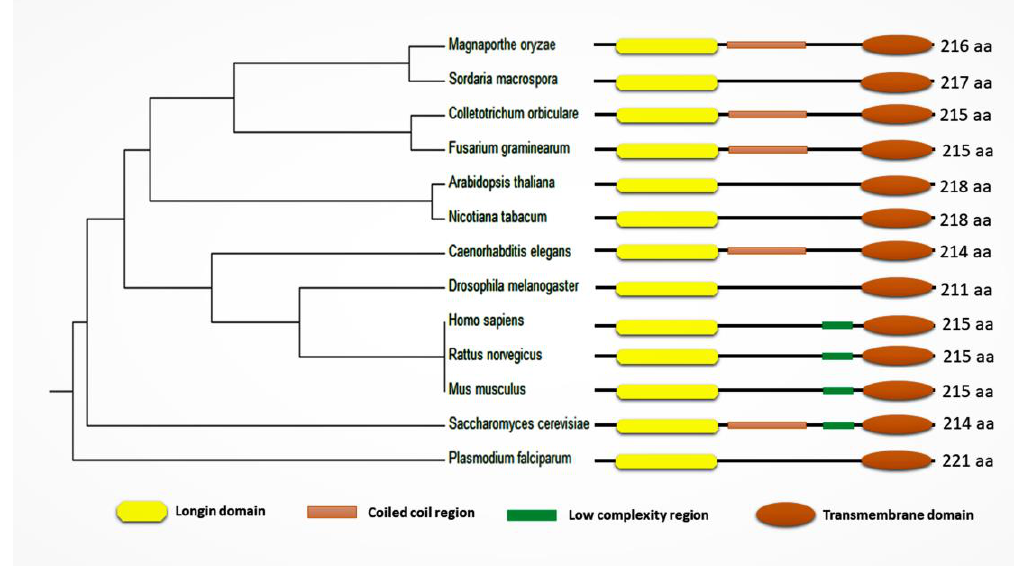
Figure 3. Phylogenetic analysis and domain characterization of Sec22 and its homologues (Sec22 of Saccharomyces cerevisiae and its homologues among different organisms including Homo sapiens , Mus musculus , Rattus norvegicus, Drosophila melanogaster , Caenorebditis elegans , Plasmodium falciparum , Arabidopsis thaliana , Nicotiana tabacum , Magnaporthe oryzae , Colletotrichum orbiculare , Sordaria macrospora , and Fusarium graminearum ). Longin domain is a conserved N-terminal domain with a